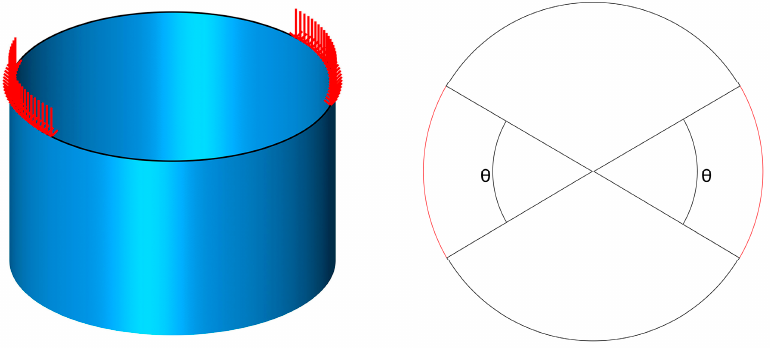
Figure 1. Tube under localized axial compression loads.